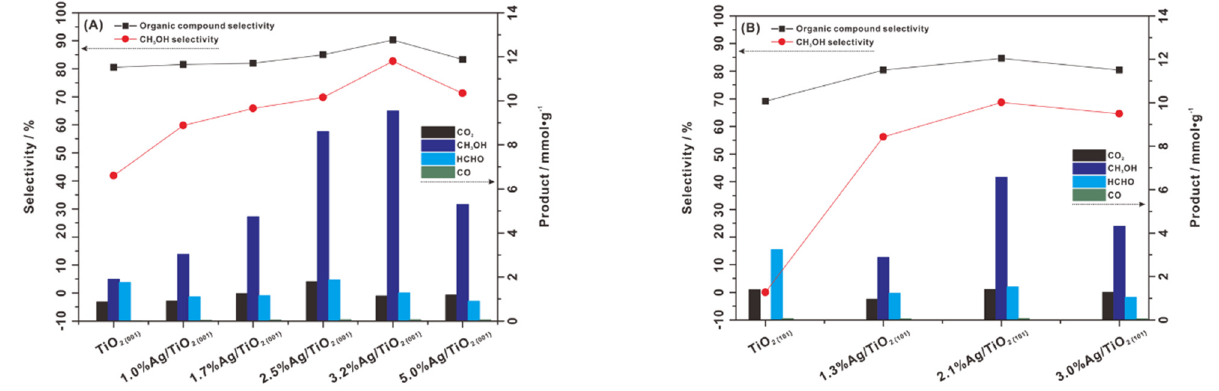
Figure 24. Methanol selectivity for ( A ) {001} dominated and ( B ) {101} dominated TiO 2 [85] . Repro- duced with permission from Feng et al. Copyright © 2022 Springer Nature.